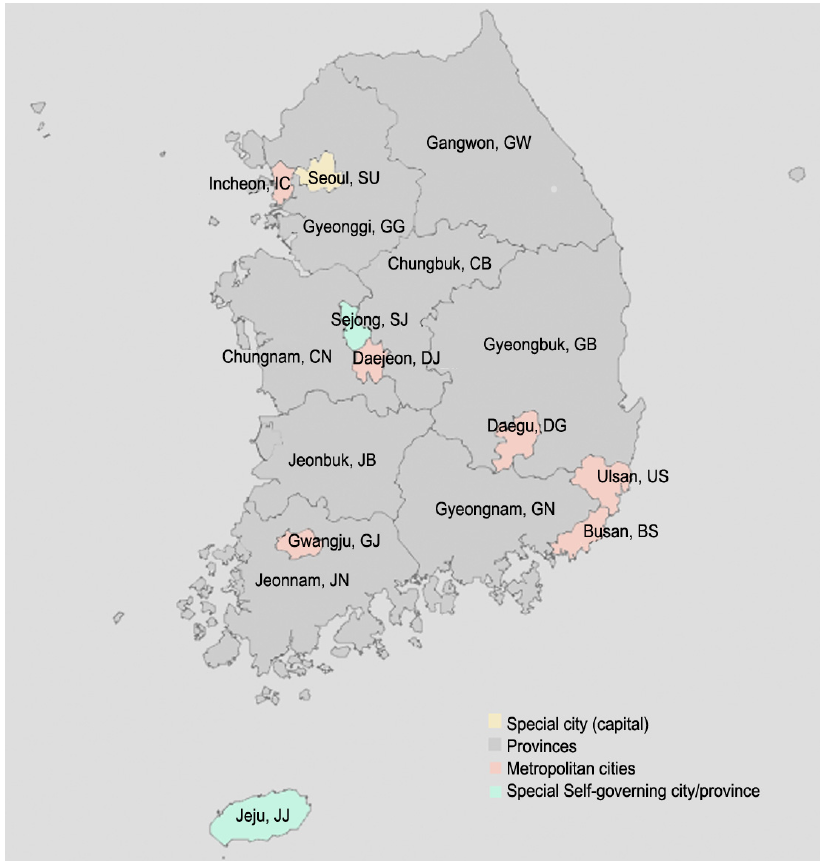
Figure 1. Regional divisions of South Korea. Seoul (SU) is the capital city of the country and colored in yellow. Those colored in pink are metropolitan cities. Sejong (SJ), the self-governing city, and Jeju (JJ), the self-governing province are colored in light green. Provinces are colored in gray.